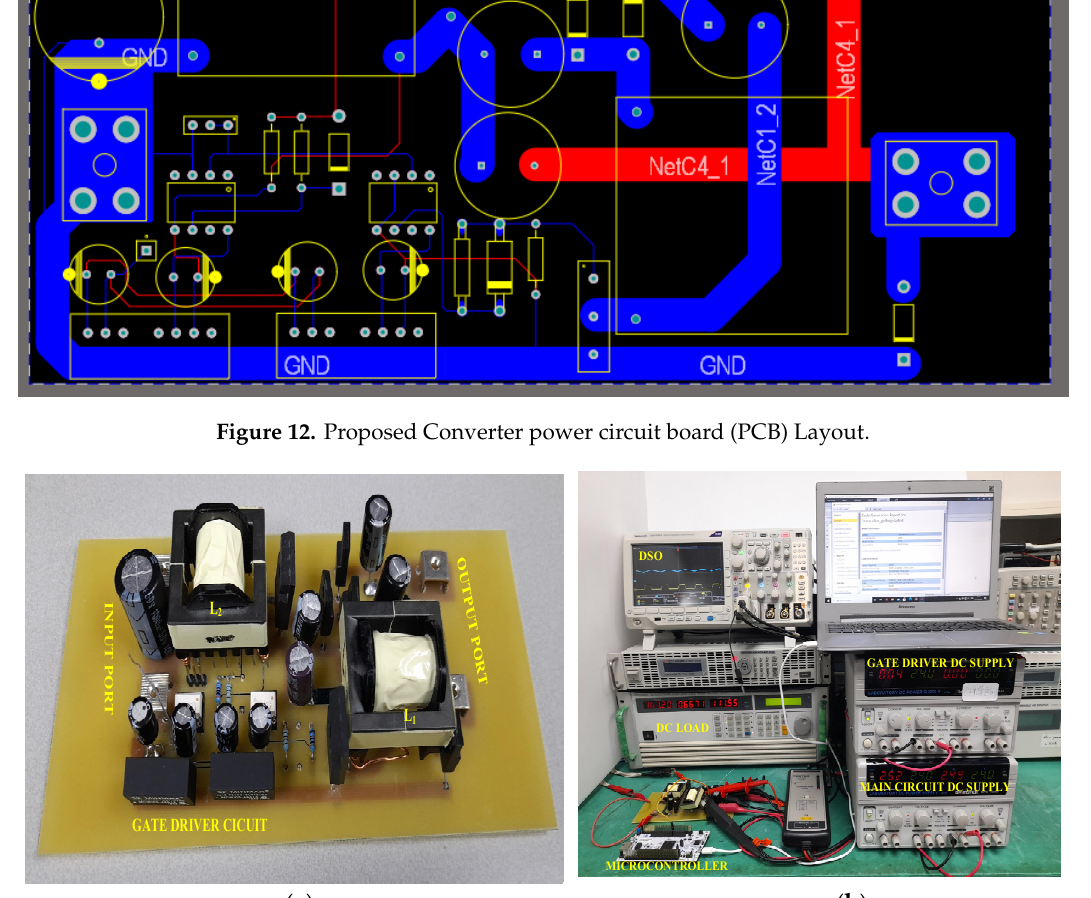
Table 3. Specifications of the proposed converter.